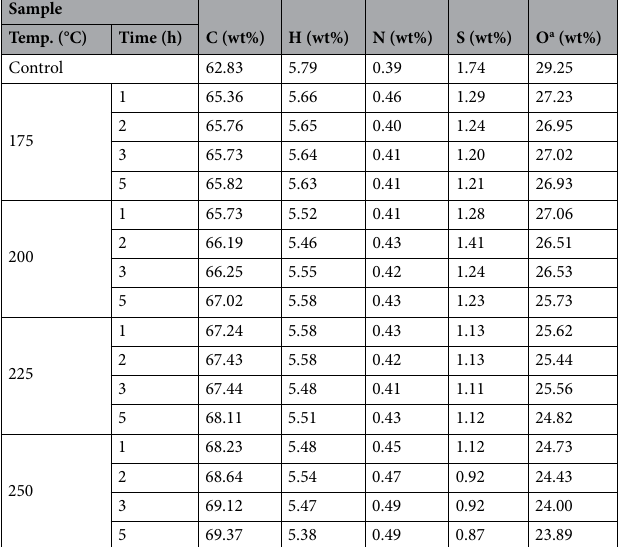
Table 1. Elemental composition of kraft-lignin-derived hydrochars. a O (wt%) = 100 − (C + H + N + S)